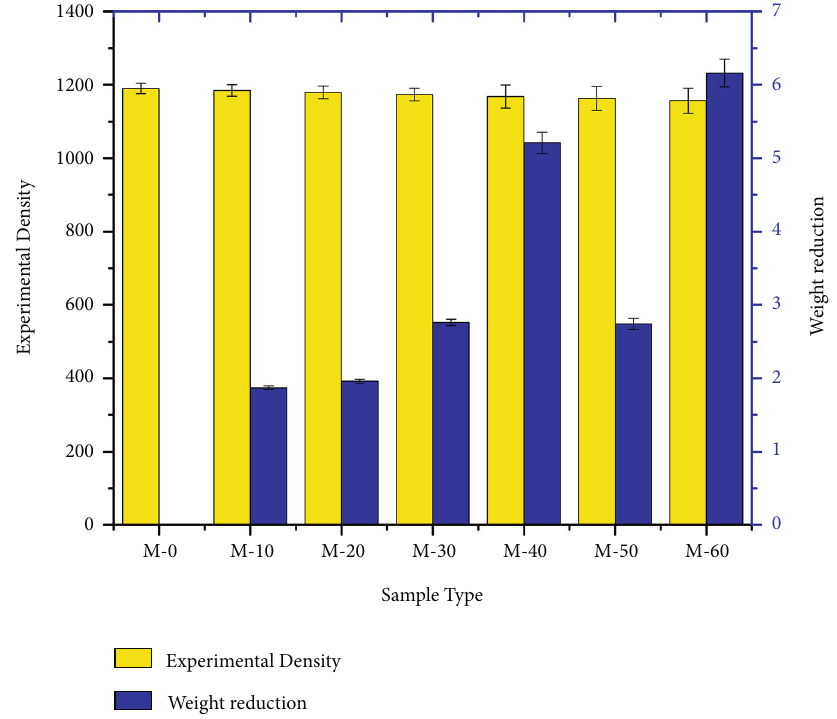
Figure 9: Experimental density and weight reduction for di ff erent sample